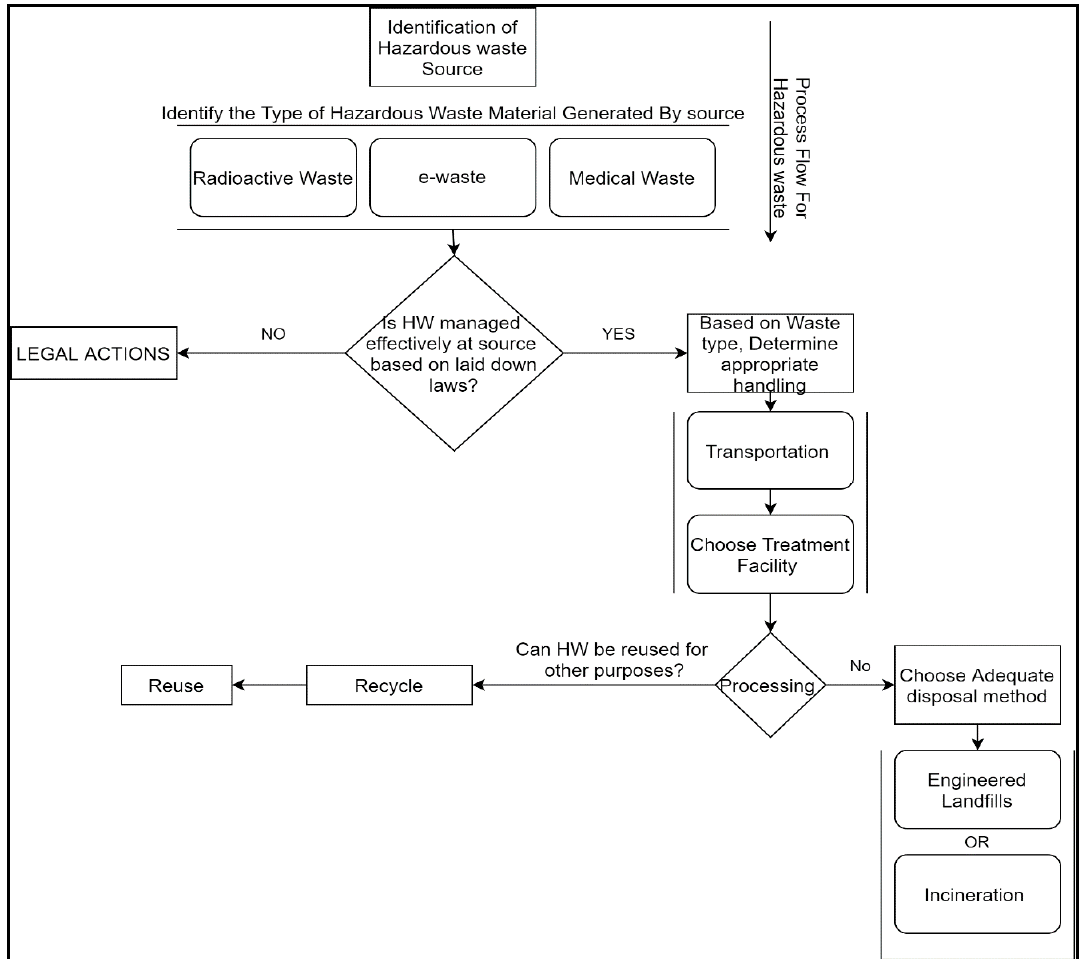
Figure 10. Hazardous Waste Management Process Flow.